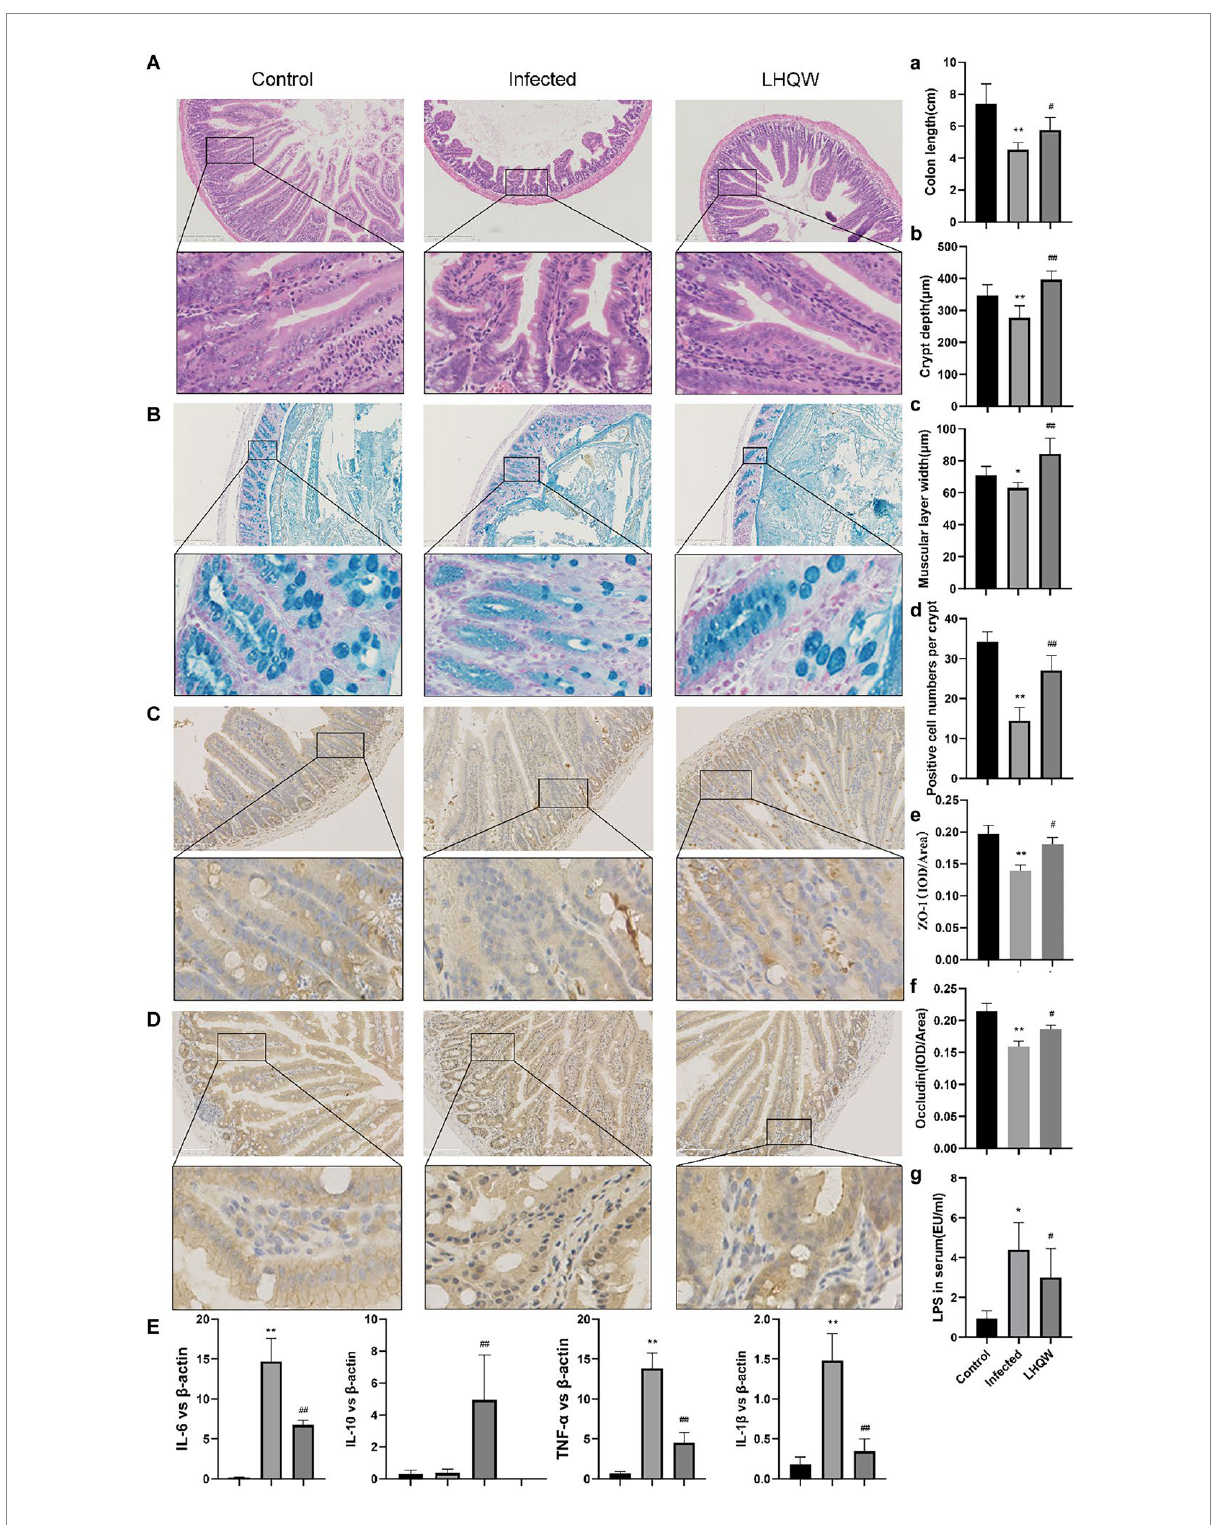
FIGURE 3 LHQW reduces intestinal wall inflammation and improves intestinal mucosal barrier function. (A) Small intestinal HE (100 times, 200 times) and (B) small intestinal recess depth (C) small intestinal muscle layer width according to HE; (A) Colon length; (B,D) the number of goblet cells; Immunohistochemical staining of intestinal mucosal barrier©otein (C) ZO-1 and (E) semi-quantitative analysis of Image J, (D) immunohistochemical staining of Occludin and (F) semi-quantitative analysis of ImageJ. (G) The content of LPS in serum of mic©as detected by ELISA. (E) the expression of inflammatory cytokines in the small intestinal wall was determined by qRT-PCR (IL-6, IL-1 β , IL-10, and TNF- α ). Compared with control group, * p < 0.05, ** p < 0.01; Compared with infected group, # p < 0.05, ## p <